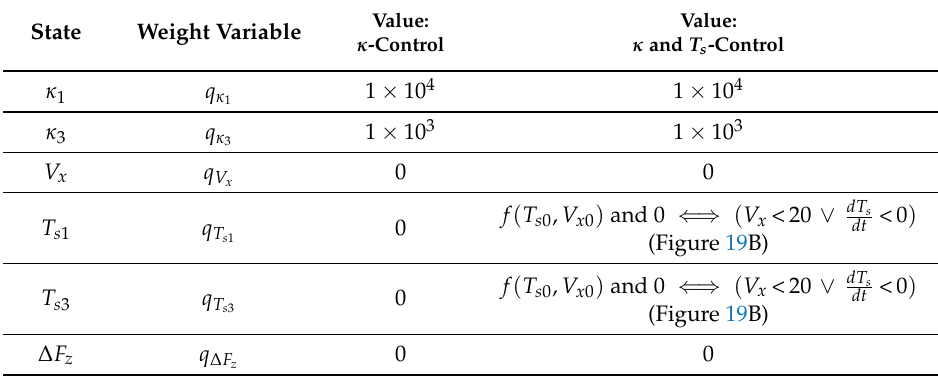
Table 5. Full-car NMPC controller